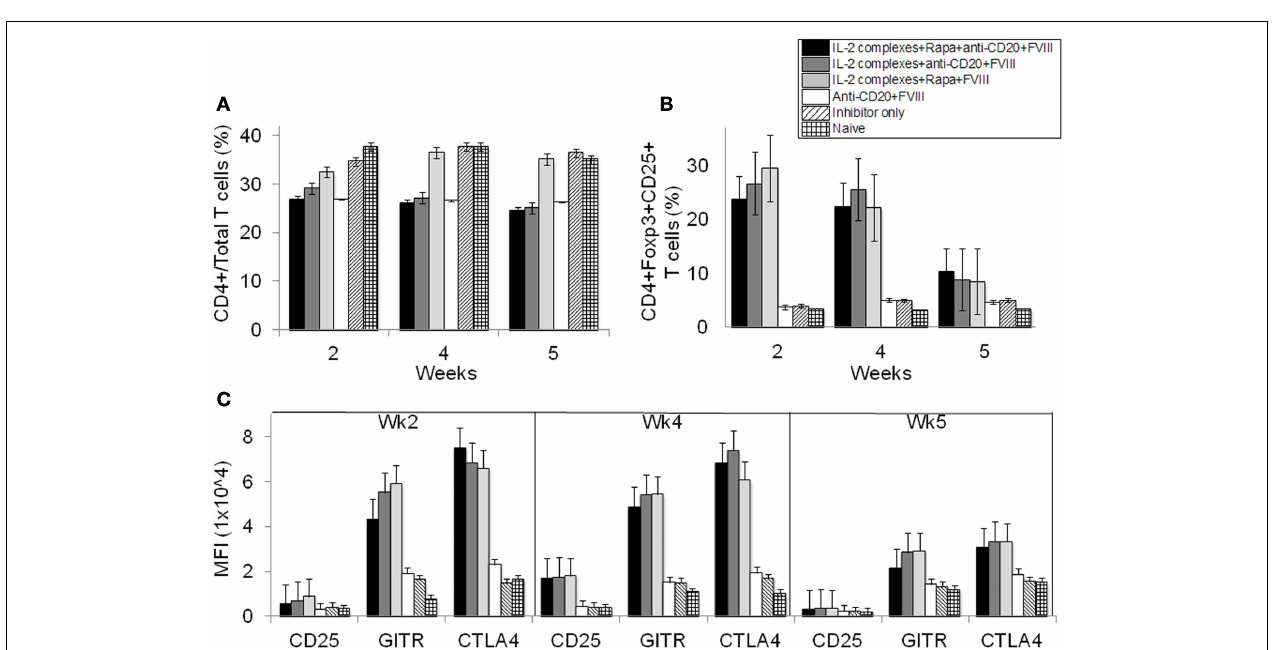
complexes + rapamycin + anti-CD20 + FVIII (black) treated mice. (A) CD4 + in totalT cells and (B) CD4 + CD25 + Foxp3 + in CD4 + T cells were stained and analyzed by flow cytometry during the treatment. (C) Blood cells were also stained and analyzed forT reg cells markers: CD25, GITR, and CTLA-4. Data shown are median fluorescence intensity (MFI) values of the three activation markers. Data shown is representative of two independent